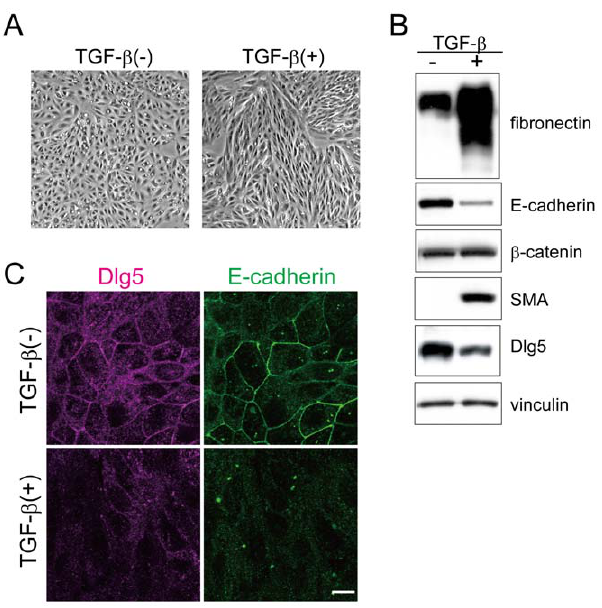
Figure 1. TGF- b -mediated EMT decreases Dlg5 expression. A: LLc-PK1 cells were incubated with 4 ng/ml of TGF- b for three days. Images were taken using phase contrast microscopy. TGF- b treatment induced morphological changes of LLc-PK1 cells. B: Three days after incubation with TGF- b , cells were lysed and immunoblotted using the indicated antibodies, which include an antibody for the epithelial marker E-cadherin, antibodies for the mesenchymal markers SMA and fibronectin, and antibodies for Dlg5 and b -catenin. As a loading control, vinculin expression was detected. C: LLc-PK1 cells were incubated with 4 ng/ml of TGF- b for three days. The cells were immunostained with anti-Dlg5 or anti-E-cadherin antibody. The scale bar indicates 10 m m. TGF- b treatment induced EMT and decreased Dlg5 expression. The results are representative of at least three independent experiments.